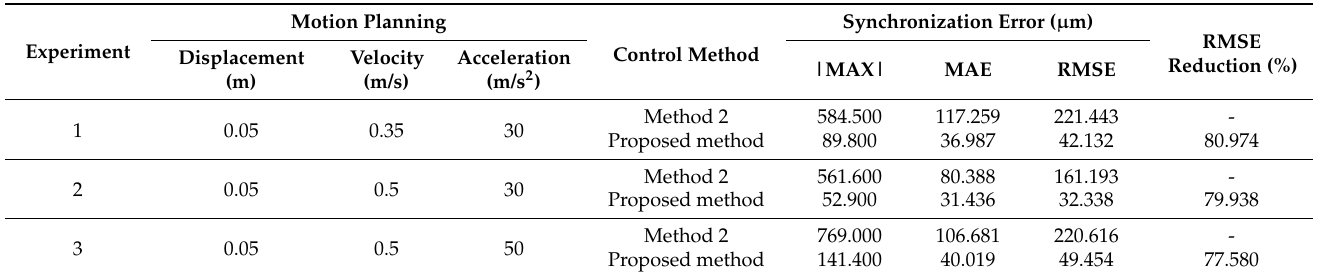
Figure 13. Synchronous motion experimental results of the dual-motor system under different synchronous control methods: ( a ) displacement comparison; ( b ) control voltage comparison (| u max | = 10V); ( c ) synchronization error comparison. Table 2. Experimental data comparison results of the synchronous motion experiments.